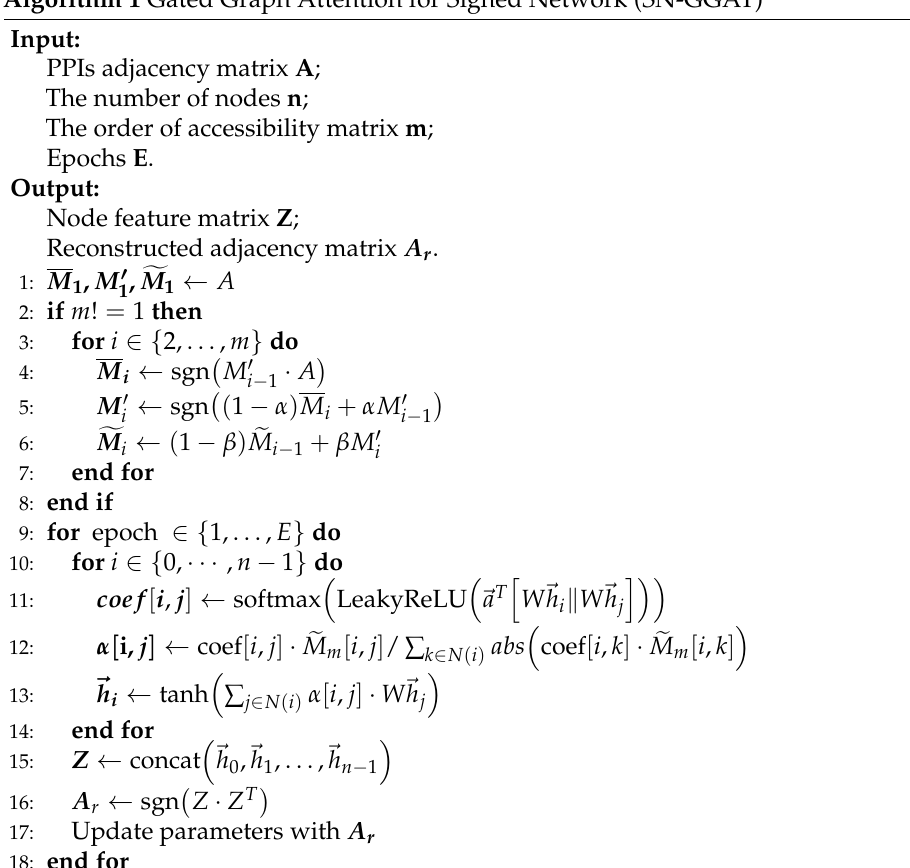
Algorithm 1 Gated Graph Attention for Signed Network